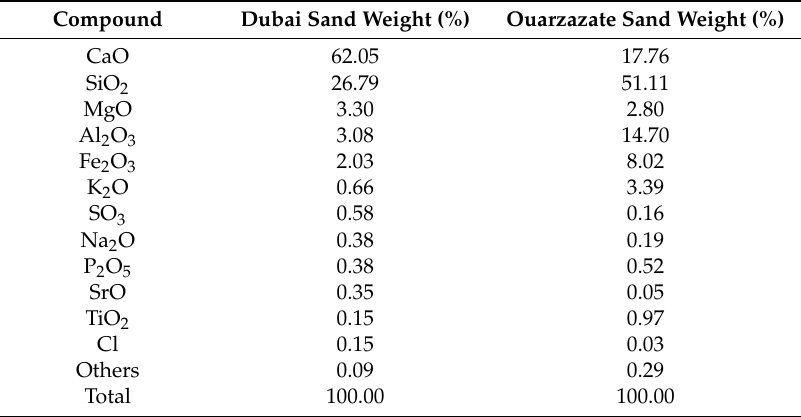
Table 1. Analysis of Dubai and Ouarzazate sands.